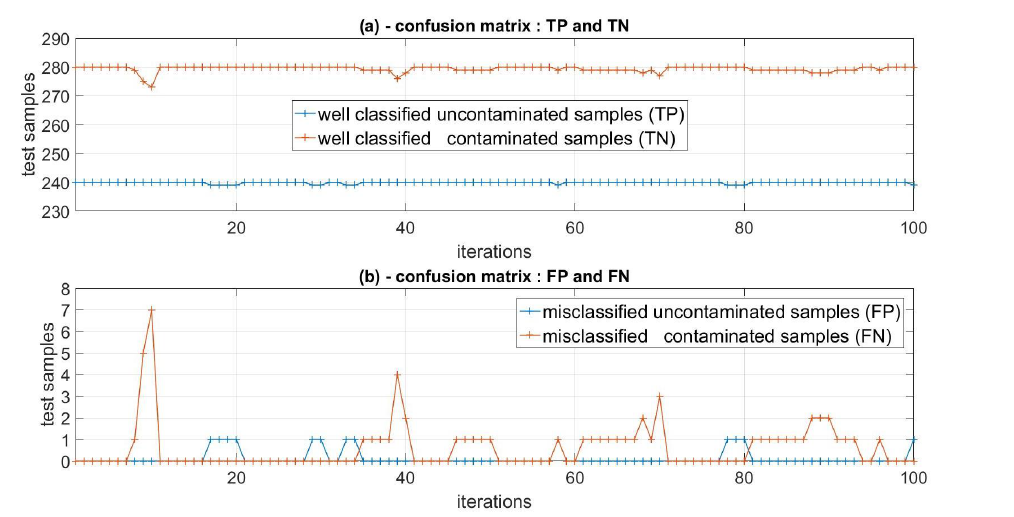
Figure 11. Confusion matrices obtained by the non-linear SVM classifier trained on the Complex nature dataset. Curve ( a ) shows the plot of the well-classified terms TP and TN, while curve ( b ) is the plot of the misclassified terms FP and FN.